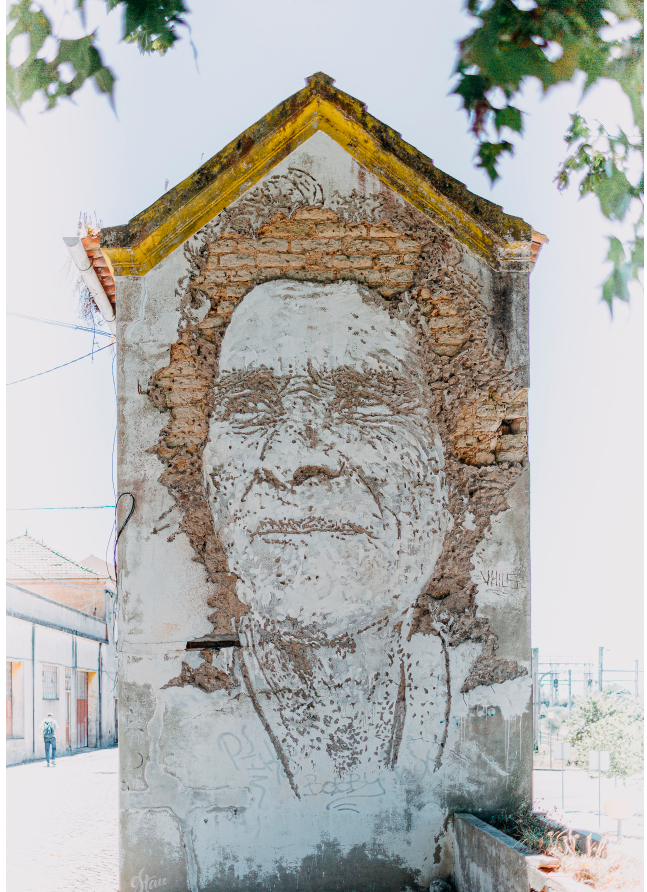
Figure 10. “Scratching the Surface Project: Dona Florinda” by Vhils (Source: Courtesy of Turismo Centro de Portugal).